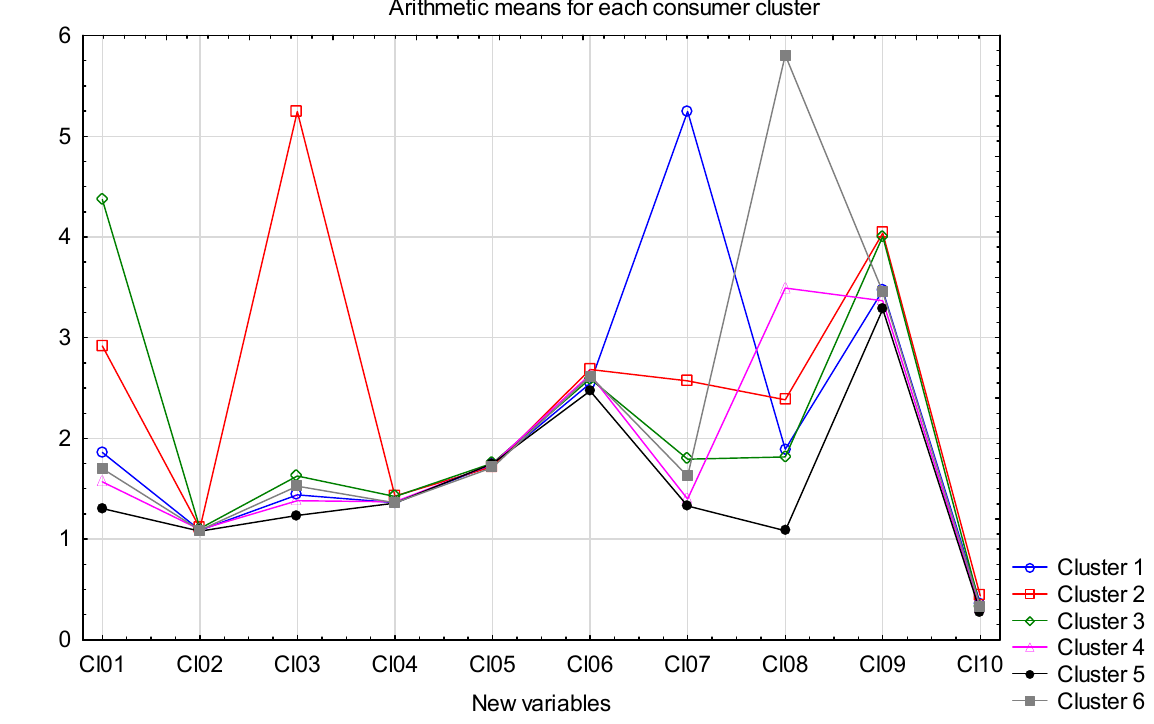
Figure 3. Arithmetic averages of new variables in the separated groups of respondents.